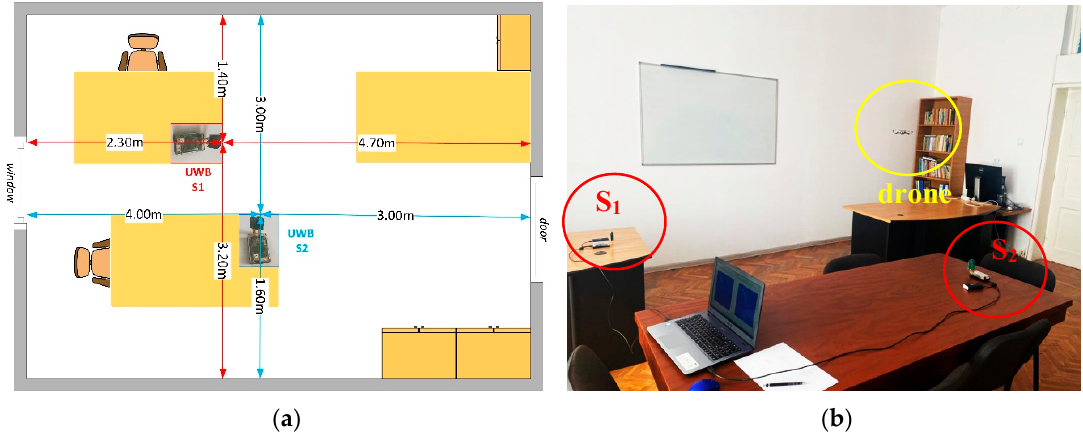
Figure 4. ( a ) The UWB sensors placement, ( b ) experimental positioning of the drone and UWB sensors.